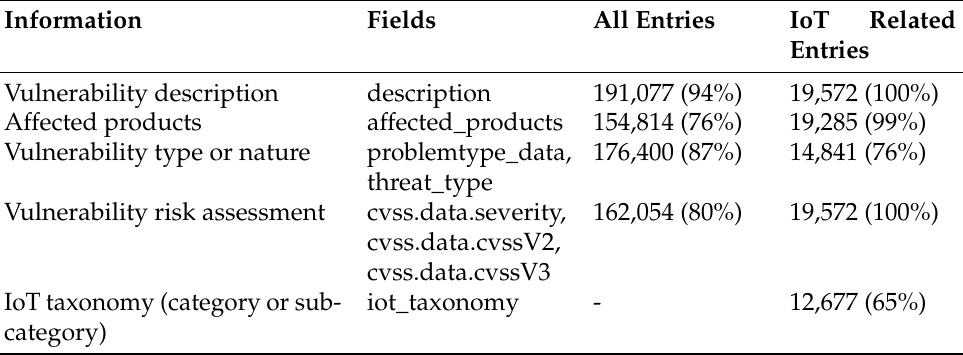
Table 5. Completeness of information in the high database